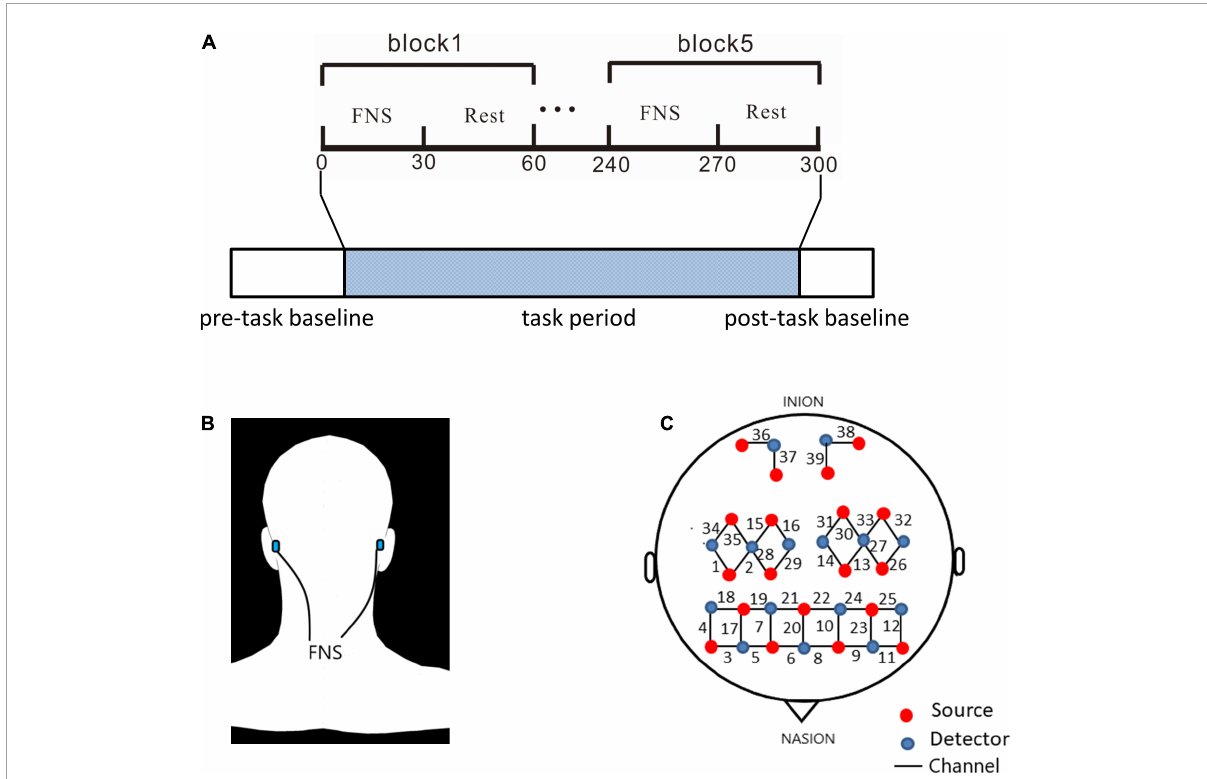
FIGURE1 Experiment equipment and procedures. (A) The experimental process consisted pre-task baseline, task period, and post-task baseline. The block design in task period is made up of 5 cycles of 2 states: 30 s of FNS and 30 s of rest. (B) Location of electrodes for FNS: bionic low-frequency biological current from 2 transcutaneous electrodes is transmitted along the mastoid process to the fastigial nucleus. (C) The source optodes, detector optodes and channels: 39 Channels according to the 10/10 system. 6 cerebral areas were measured: LPFC, RPFC, LMC, RMC, LOC, and